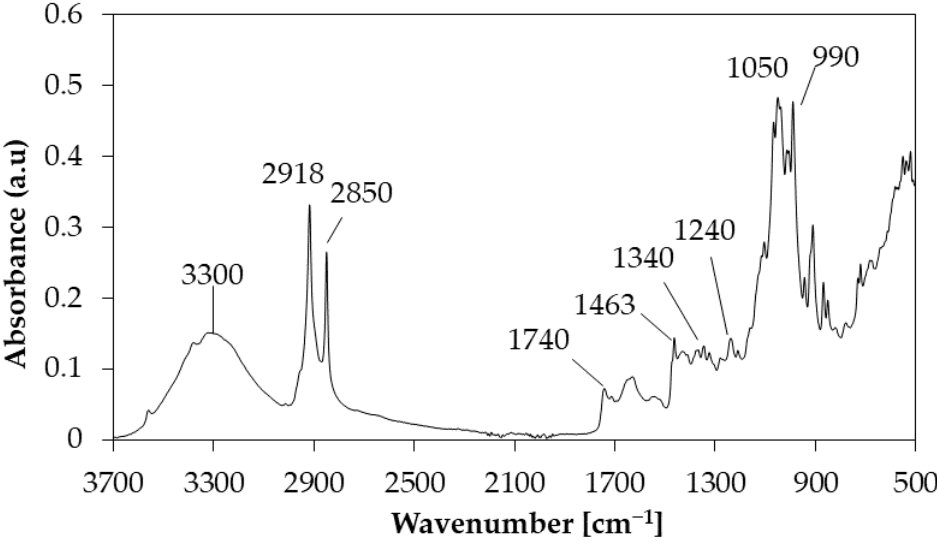
Figure 1. FTIR spectra of sugarcane residual biomass.